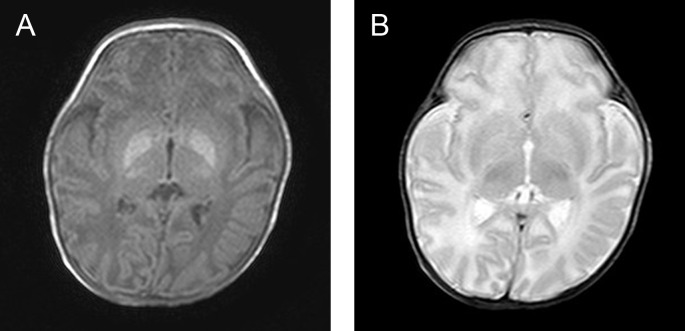
T1 and T2 weighted MR imaging at day 7 (patient number 21).A: There was bilateral, symmetric, abnormal increased signal intensity in the GP on T1-weighted imaging. B: The above-mentioned lesions were not apparent on T2-weighted images.